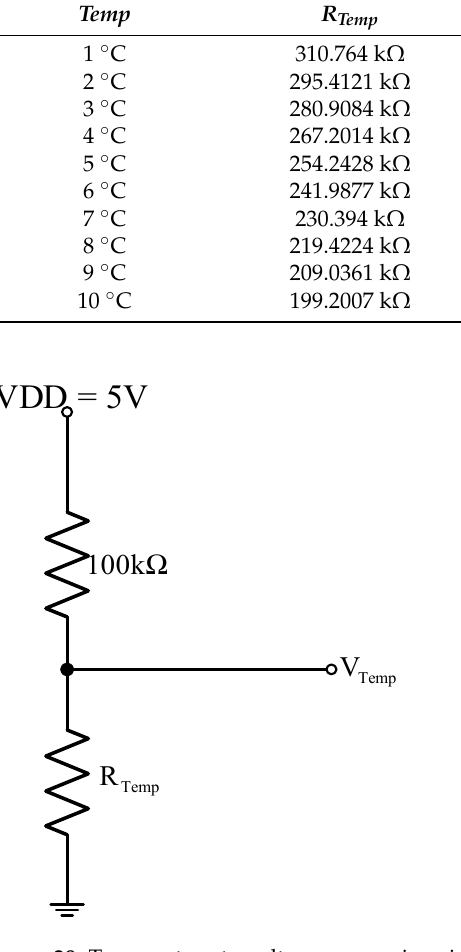
Figure 28. Temperature to voltage conversion circuit . Table 9. The relationship between the temperature and the thermistor [24].